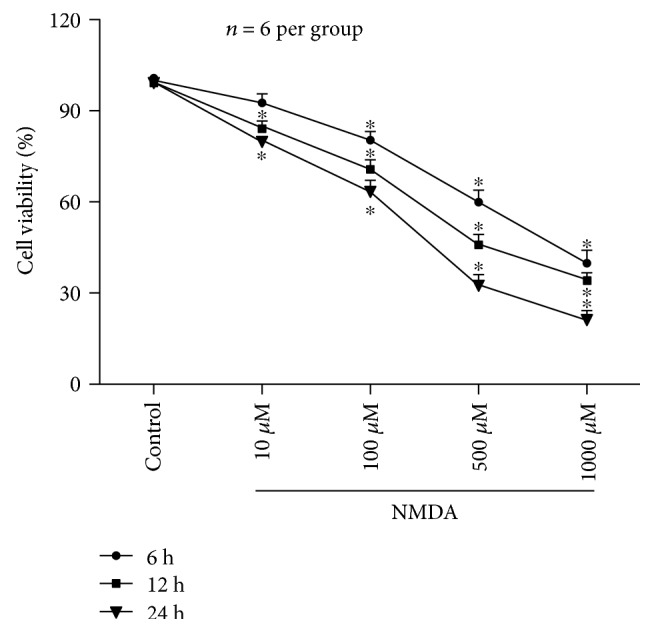
Effects of different concentrations (10–1000 μM) of NMDA on cell viability in SH-SY5Y cell. NMDA (100 μM, 500 μM, and 1000 μM) decreased cell viability at 6 h, 12 h, and 24 h after NMDA exposure for 2 h (P < 0.05). Only at 12 h and 24 h after NMDA (10 μM), treatment was significant (P < 0.05). Numbers represent the percentage of the living cells normalized to the control. Each value represents the mean ± S.E.M. of six independent experiments. ∗P < 0.05 versus the control group.